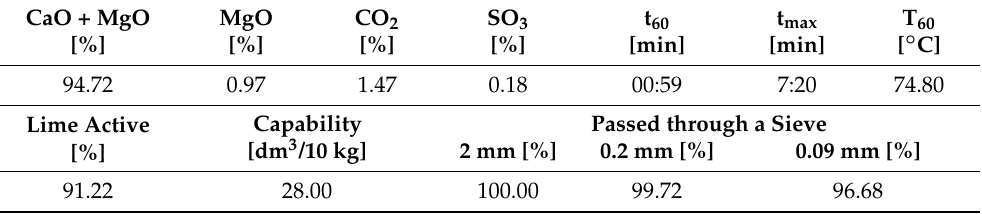
Table 1. Characteristics of ground